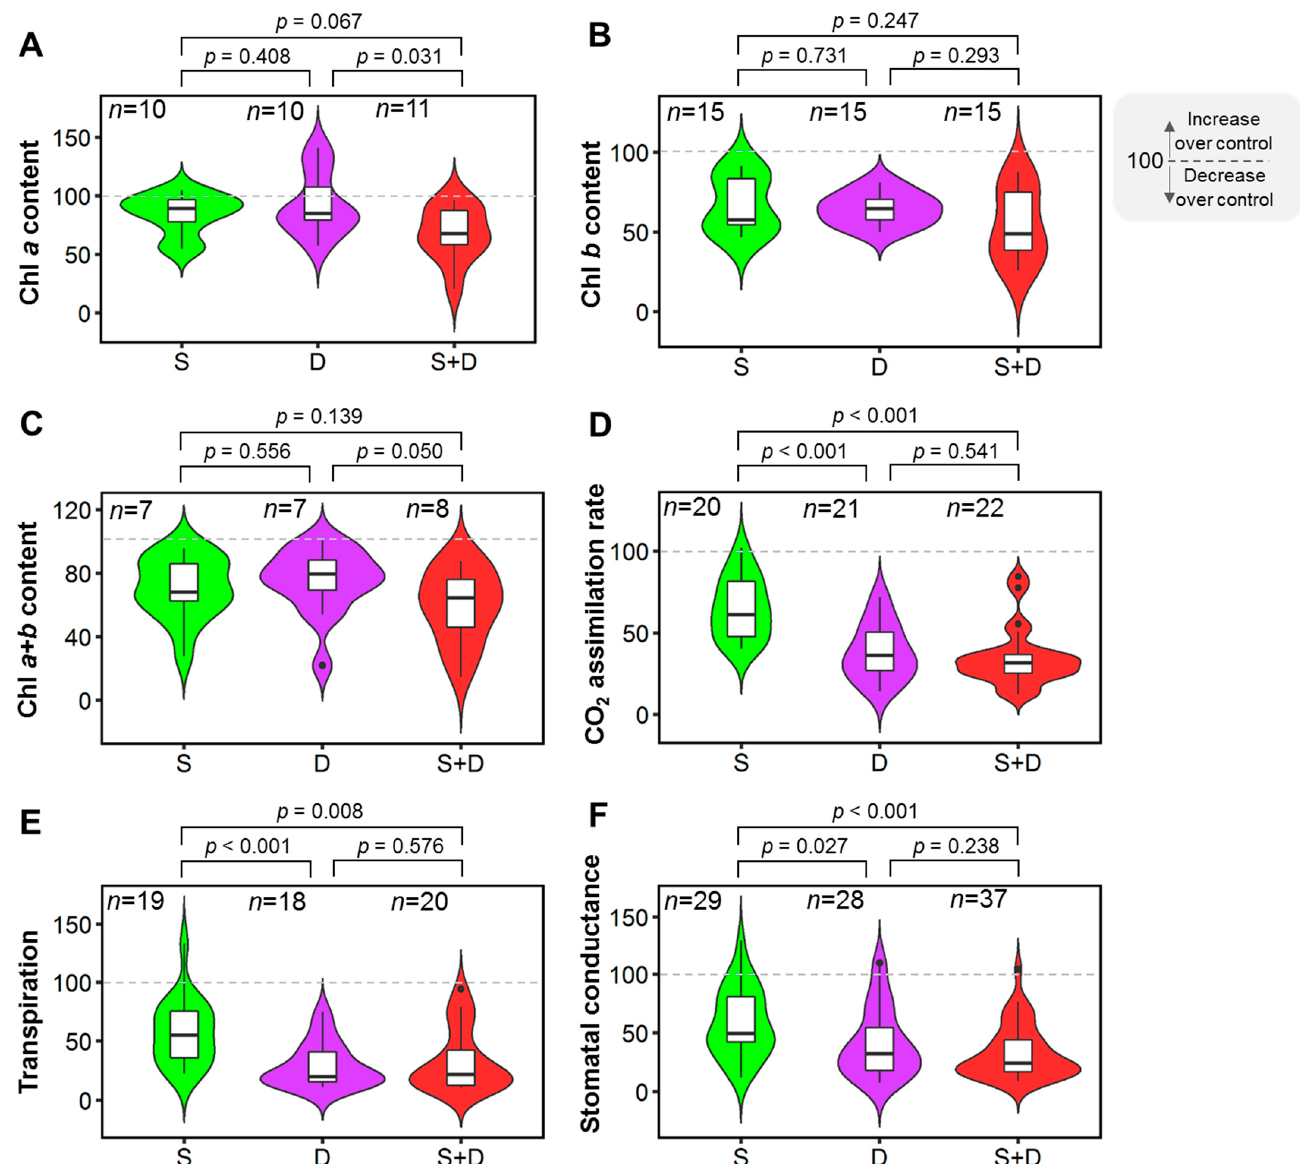
Figure 3. Effects of drought (D), salinity (S), and their combined (S+D) stress on plants’ photosynthetic efficiency. ( A ) Chlorophyll (Chl) a content, ( B ) Chl b content, ( C ) Chl a+b content, ( D ) net CO 2 assimilation rate ( A ), ( E ) transpiration rate ( E ), and ( F ) stomatal conductance (G s ). The % of control treatment is presented in the figures. The statistical differences were assessed using Welch’s t -test where the p value indicates the level of statistical difference, and a p value less than 0.05 was considered statistically significant. n indicates the number of